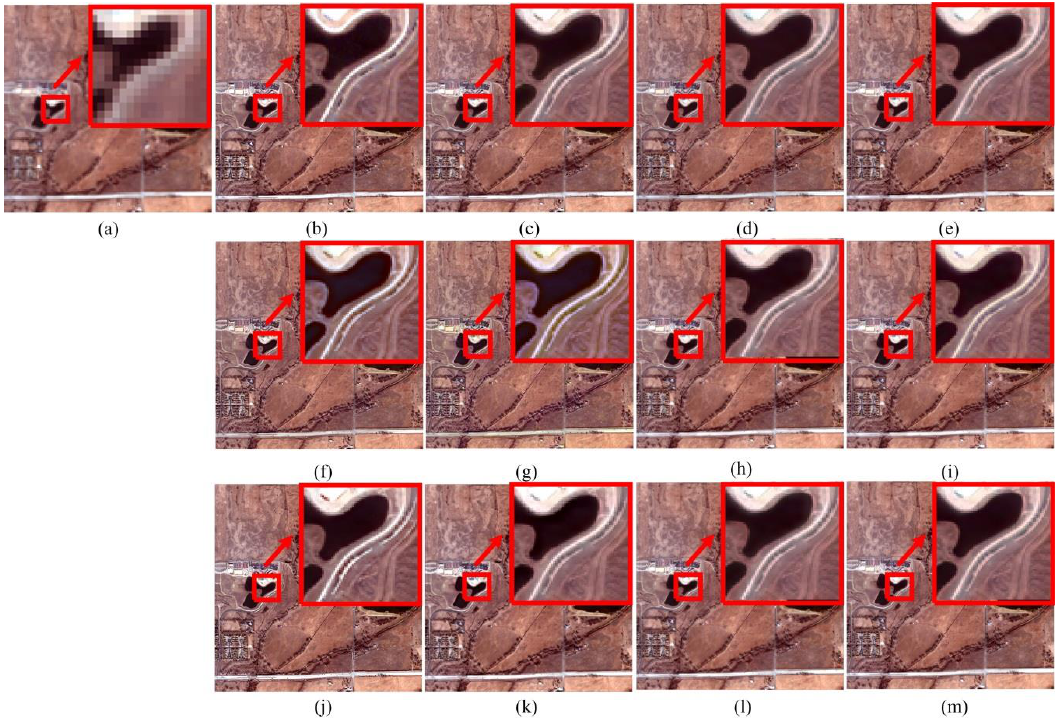
Figure 12. Pansharpening results of Boulder dataset. ( a ) MS. ( b ) Ground-truth image. ( c ) PPCNN. ( d ) GS. ( e ) PCA. ( f ) BT. ( g ) IHS. ( h ) ATWT. ( i ) AWLP. ( j ) CBD. ( k ) MOF. ( l ) RAWLP. ( m ) FSR.